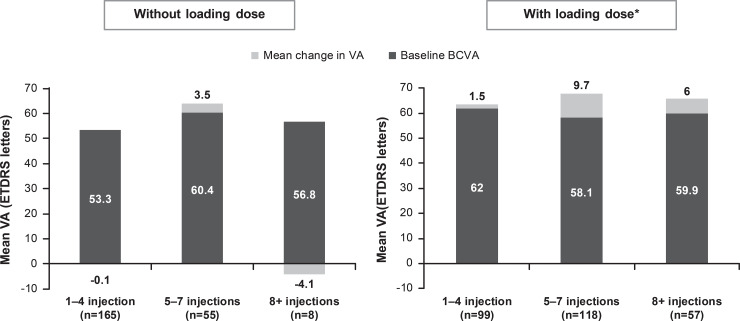
Mean change in visual acuity in patients with and without loading doses (primary treated eye set).*Three initial consecutive injections at 4 weekly intervals. Observed dataset for VA change. The primary treated eye set included all primary treated eyes in patients included in the safety set. The safety set consisted of patients in the enrolled set who were treated with at least one dose of ranibizumab during this study or prior to the start of the study and had at least one safety assessment after the first treatment. For treatment-naïve eyes, the date of first on-study injection with ranibizumab was considered the baseline date. For the 1-year time period, all patients with non-missing baseline VA and year 1 VA performed anywhere between Day 319 and Day 409 but who had been in the study for at least 365 days from baseline to last follow-up date were included in the analysis.BCVA, best-corrected visual acuity; ETDRS, Early Treatment Diabetic Retinopathy Study; VA, visual acuity.